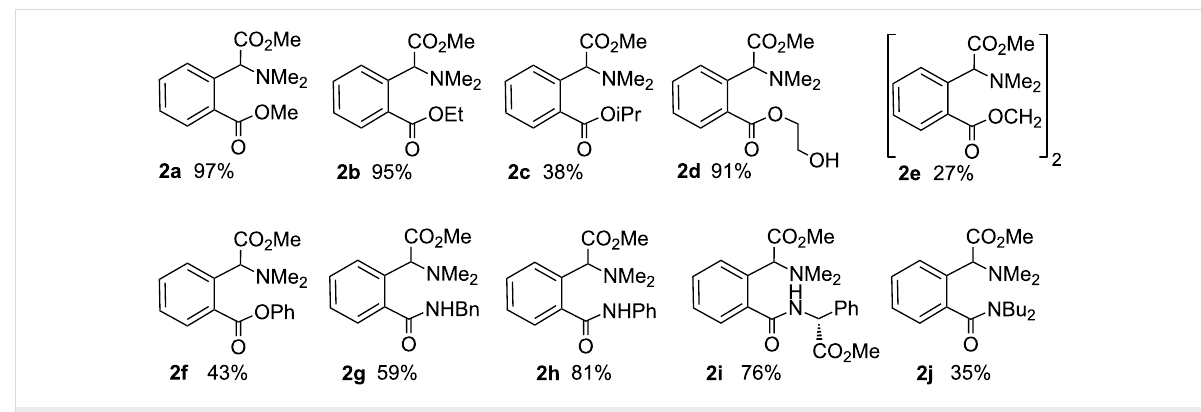
Figure 1: Scope of the carbonylation reaction.